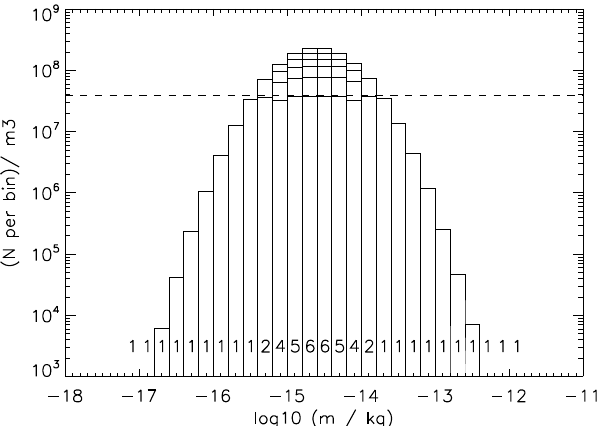
Fig. A1. Initialisation of a log-normal size distribution with a dis- Fig. 311. Initialisation of a lognormal size distribution with a dis- crete set of SIPs. The ice mass distribution is discretised into bins crete set of SIPs. The ice mass distribution is discretised into bins with exponentially increasing bin sizes. Once the ice crystal num- with exponentially increasing bin sizes. Once the ice crystal num- ber in a bin ν b is above ν min , SIPs are created for this bin. If ν b is ber in a bin ν b is above ν min , SIPs are created for this bin. If ν b is above ν max , several SIPs are created each representing around ν max ice crystals. The labels show the number of SIPs in every bin. The above ν max , several SIPs are created each representing around ν max threshold level ν max is given by the dashed ice crystals. The labels show the number of SIPs in every bin. The threshold level ν max is given by the dashed line.